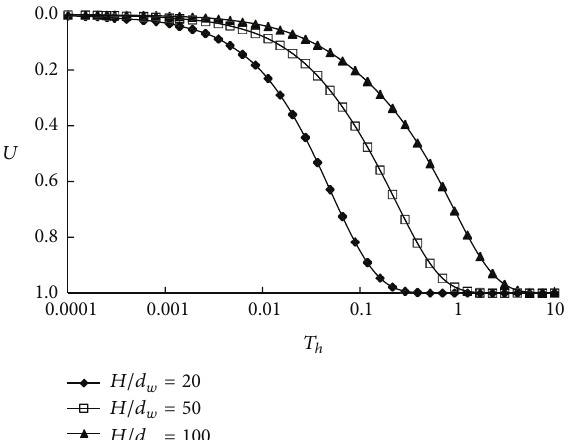
Figure 5: Influence of 𝐻/𝑑 𝑤 on consolidation